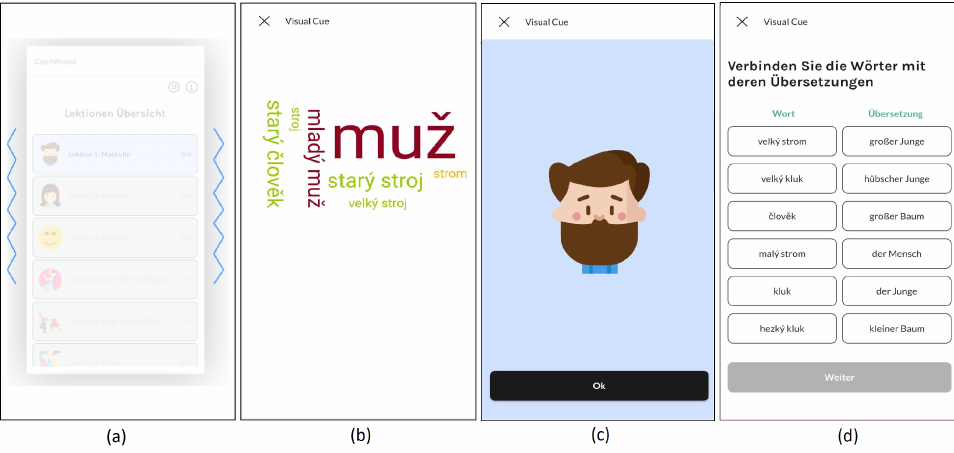
Figure 8. The four revised designs for task resumption cues for mobile language learning, ( a ) Vibro- Tactile Cue , ( b ) Color and Icon Cue , ( c ) WordCloud Cue , and ( d ) Interactive Test Cue